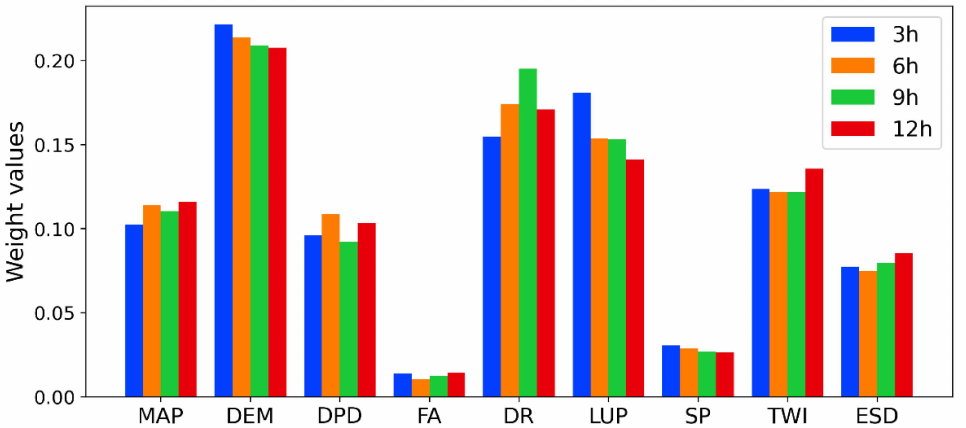
Figure 7. Weights of each flood hazard factor, as listed in Table